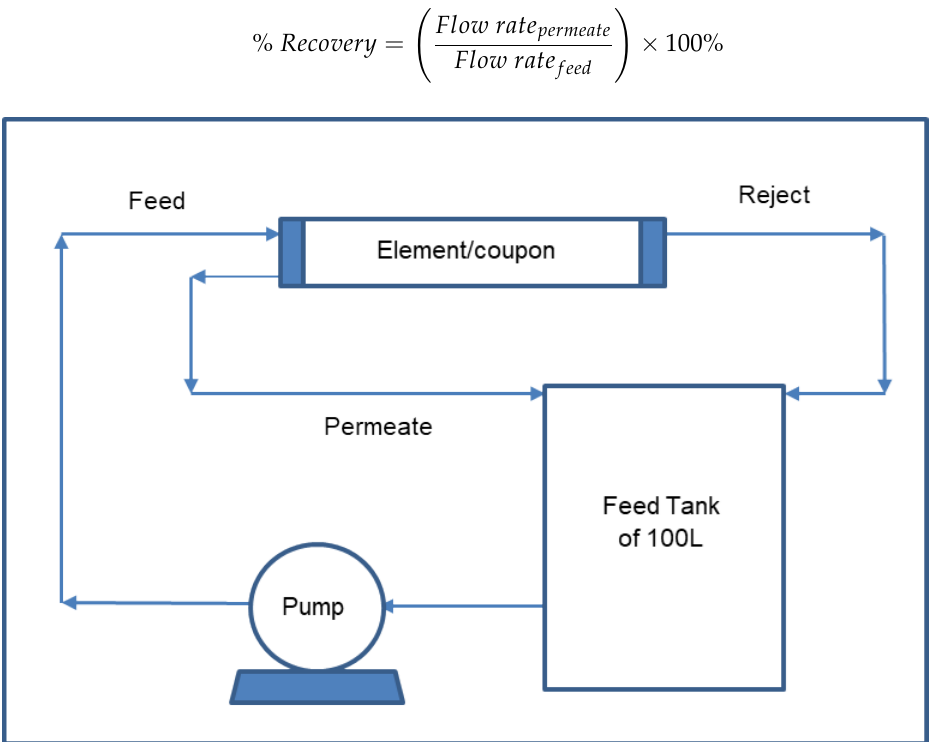
Figure 4. Schematic diagram of the setup used in this study to evaluate the 1812 and 2514 elements.